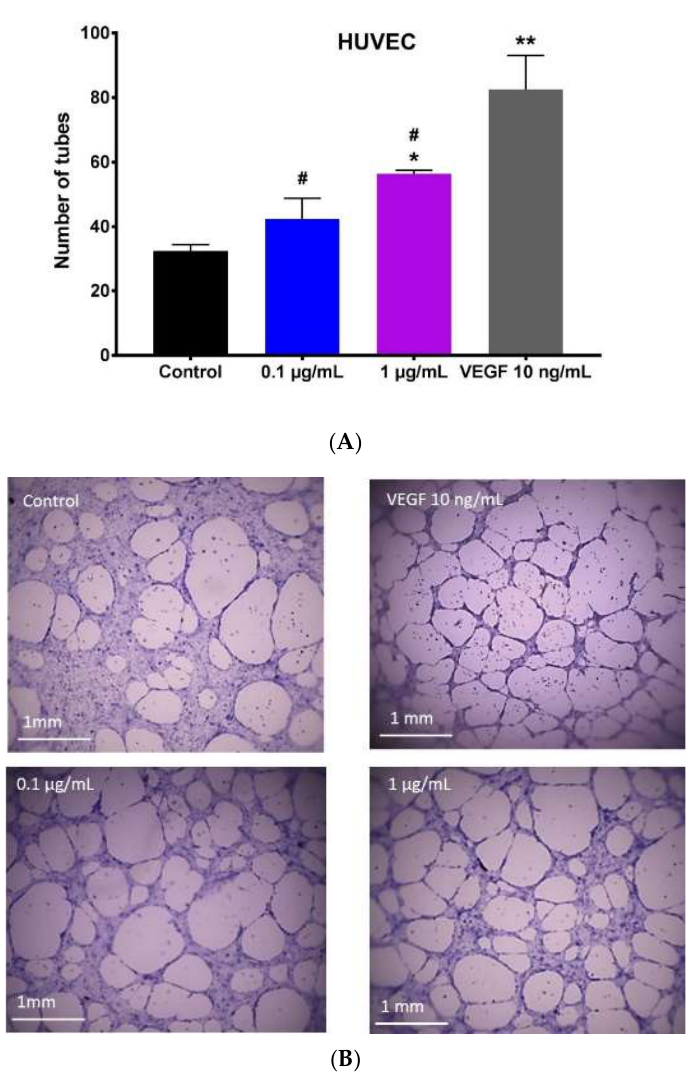
Figure 4. ( A ) The average number of tubes formed among HUVECs after 8 h of incubation on growth factor reduced BD matrigel, in which * represents a significant difference ( p ≤ 0.05 and ** p ≤ 0.01) from the control group, which was calculated using Graph-Pad Prism 7.03 to determine the significance between each experimental group and control. # represents a significant difference ( p ≤ 0.05) among treated groups and VEGF positive control. ( B ) Representative images are shown for the treatment with growth media alone, 0.1 µg/mL, and 1 µg/mL hypermongone C. Fewer tubes were formed in the group including untreated cells, with many of them remaining as individual single cells.